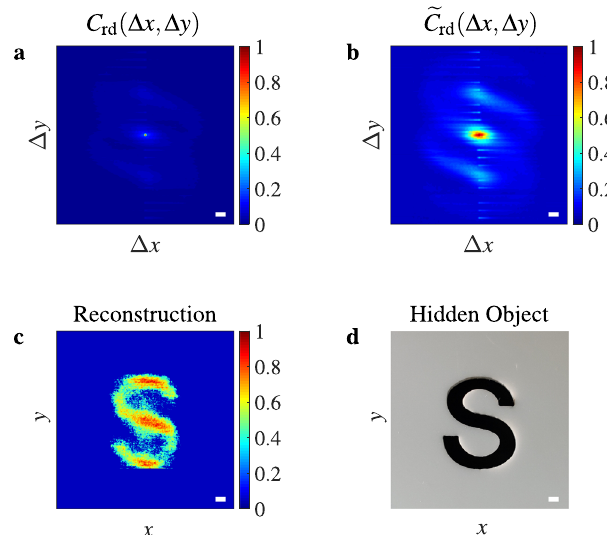
Fig. 4 Imaging of a hidden object ’ S ’ in a random corridor with two corners. a Cross-correlation of the I rd ( r c ; r o + Δ ρ ) before renormalization. b Cross-correlation of the I rd ( r c ; r o + Δ ρ ) after renormalization. c Object image reconstructed from the cross-correlation in ( b ) by a phase-retrieval algorithm. d Photo of the hidden object. System parameters for imaging: ^ l ¼ 50, R = 2.87 and N = 10 4 . Scale bar: 1 sub